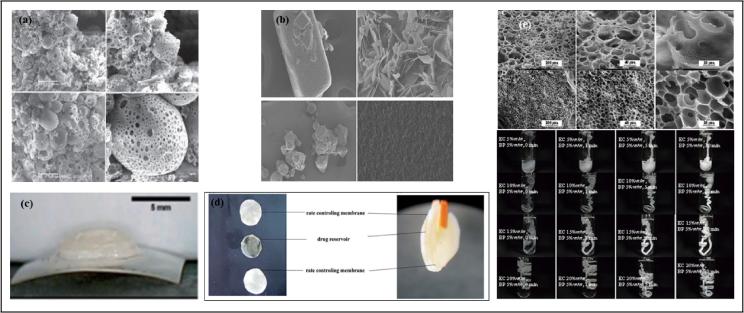
Ethylcellulose (a) microsponge gel for topical delivery (adapted from Bothiraja et al., 2014), (b) anesthetic and analgesic loaded transmucosal patch (adapted from Nidhi et al., 2016), (c) buccal disc for oromucosal drug delivery (adapted from Yildir et al., 2018), (d) timolol maleate-brimonidine tartrate ocular inserts (adapted from Ravindran et al., 2014), (e) in situ forming gel containing antimicrobials (adapted from Phaechamud and Mahadlek, 2015).